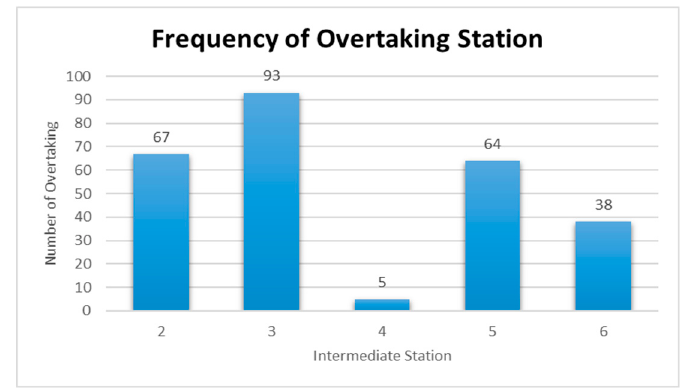
Figure 23. Frequency of Overtaking Station for Case 6.